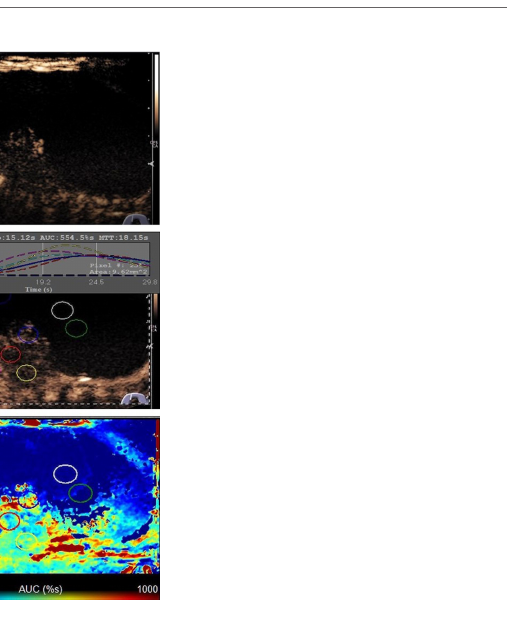
FIGURE 2 | CEUS images of predominantly cystic papillary thyroid carcinoma. (A) CEUS image showed a slight enhancement from the bottom of the solid portion at 9 s. (B) The enhancement from the bottom to the periphery of the solid portion at 15 s. (C) All the solid portions of this nodule heterogeneously enhanced and reached its peak [time to peak (TTP)] at 23 s. (D) TICs displayed the wash-in time of 9 s, TTP of 15 s, PI of 31.9%, and AUC of 554.5% s for the solid portion of this thyroid nodule, and the cystic portion of the nodule has no enhancement. (E) The parametric color map showed that the solid portion was almost a majority of green with a little blue, the cystic portion was totally blue, which indicated that the PIs for the center of the solid portion was almost equal to those of the periphery of the solid portion. (F) The parametric color map showed the solid portion was heterogeneous with a mixture of green, yellow, and red, and the cystic portion was totally blue, which indicated that the AUC for the center of the solid portion was lower than those of the periphery of the solid